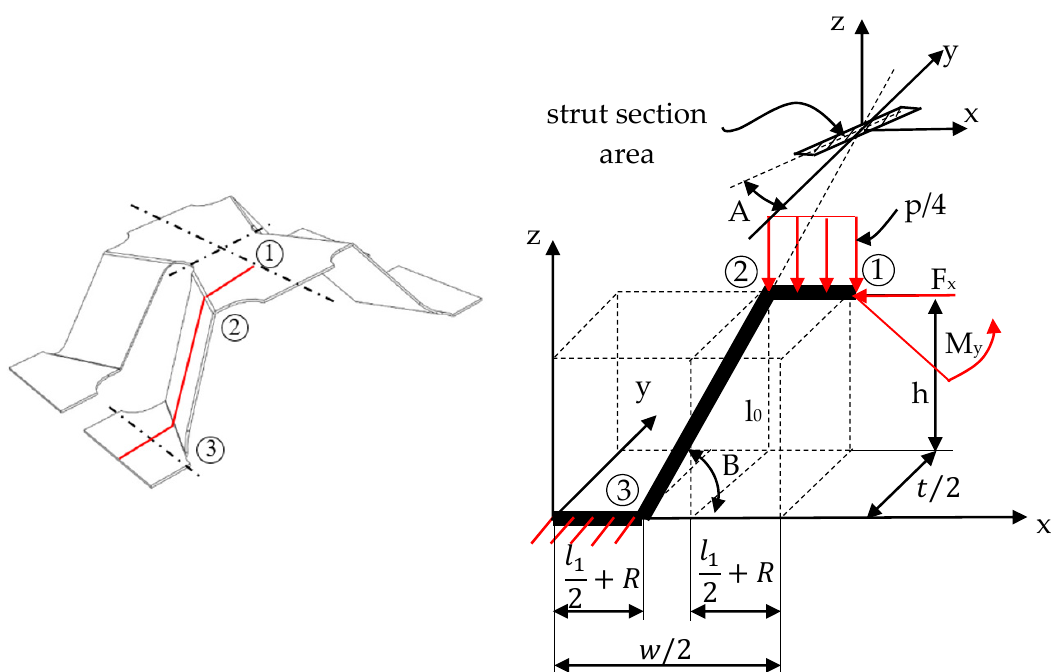
Figure 4. Quarter of unit cell under out-of-plane compression loading.